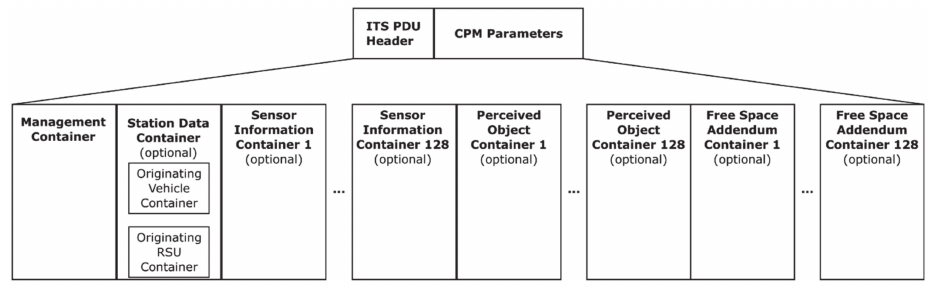
Figure 2. Data structure of a collective perception message